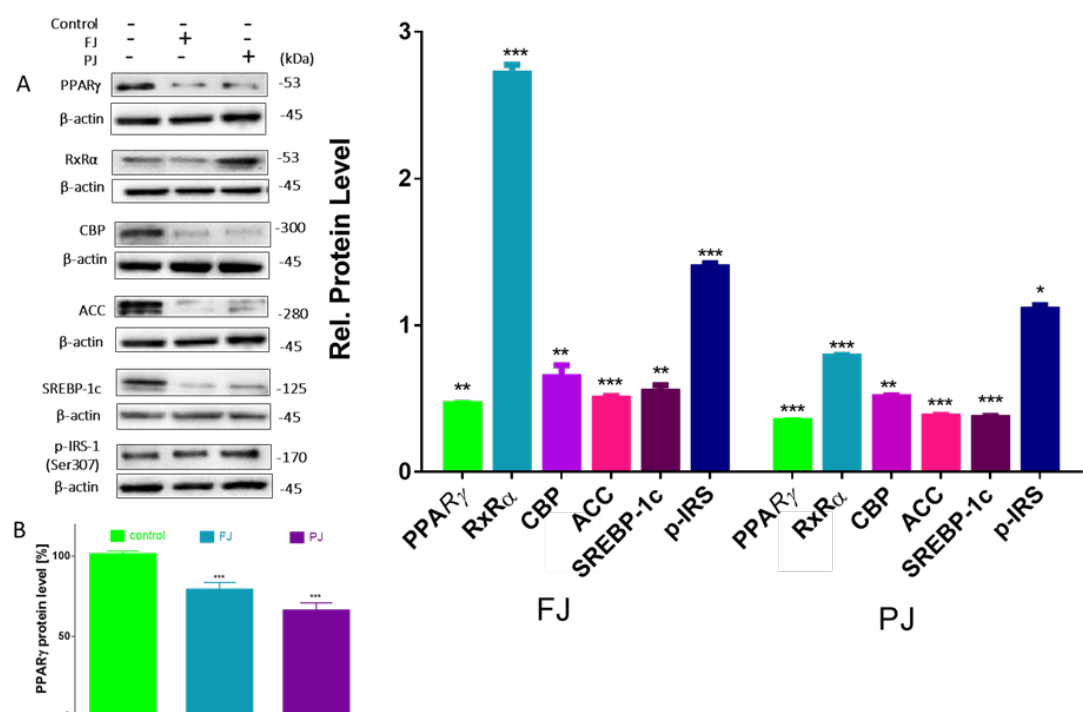
Figure 8. Effect of V. opulus FJ and PJ preparations on the relative protein level of crucial proteins involved in adipogenesis and lipogenesis determined by Western blot analysis in differentiated 3T3-L1 cells ( A ); the level of PPARγ determined with ELISA assay in nuclear fraction ( B ); control cells were not exposed to any compound; the values are means ± standard deviations, n ≥ 5; statistical significance was calculated between treatment and control cells (untreated), * p ≤ 0.05, ** p ≤ 0.01, *** p ≤ 0.001.